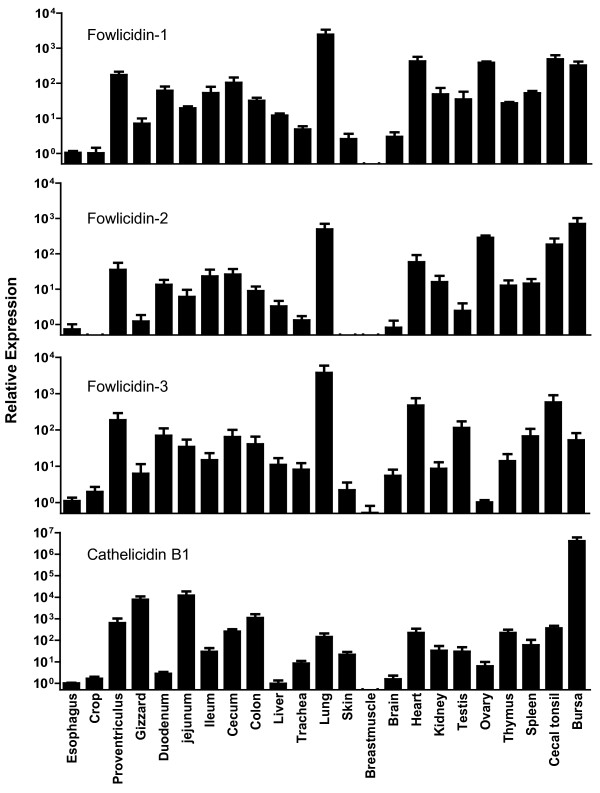
Tissue Expression pattern of four chicken cathelicidins. All tissues were collected from three 28-day-old broiler chickens and subjected to RNA isolation and real-time PCR using gene-specific primers. Expression levels of all tissues were calculated relative to that of the esophagus using GAPDH as a reference gene. Each bar represents mean ± standard error of three chickens.